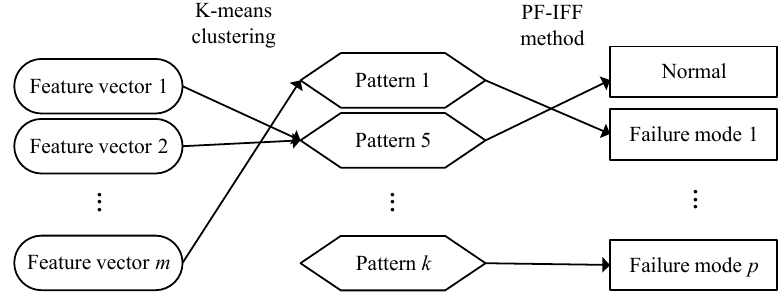
Figure 3. Process for identifying abnormal patterns.